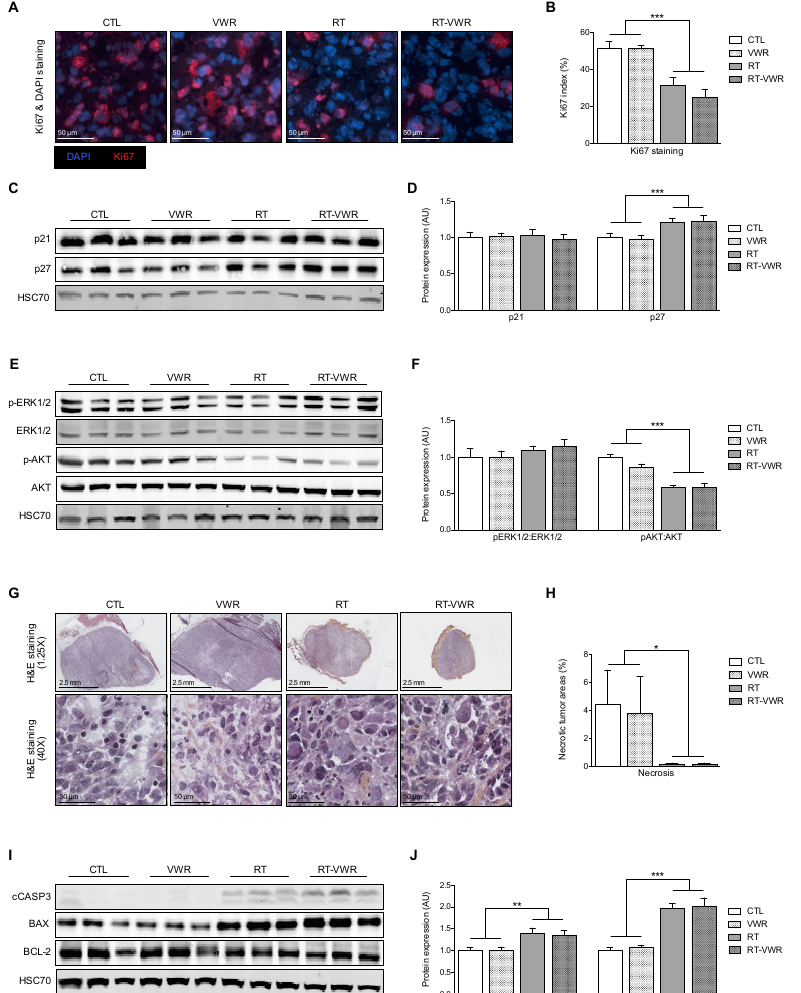
Figure 5. VWR does not modulate the effects of RT on tumor cell death, proliferation and survival. ( A ) Representative images of Ki67 (red) and DAPI (blue) staining; ( B ) Percentage of Ki67 positive cells; ( C ) Representative Western blot images of p21 and p27 proteins; ( D ) Quantification of p21 and p27 protein expression; ( E ) Representative Western blot images of p-ERK1/2, ERK1/2, p-AKT, and AKT proteins; ( F ) Quantification of p-ERK1/2, ERK1/2, p-AKT, and AKT protein expression; ( G ) Representative images of H&E staining; ( H ) Percentage of necrotic areas; ( I ) Representative Western blot images of cCASP3, BAX and BCL-2 proteins; ( J ) Quantification of cCASP3 and BAX:BCL-2 protein expression. Data are represented as means ± SEM. * p < 0.05; ** p < 0.01; *** p < 0.001.